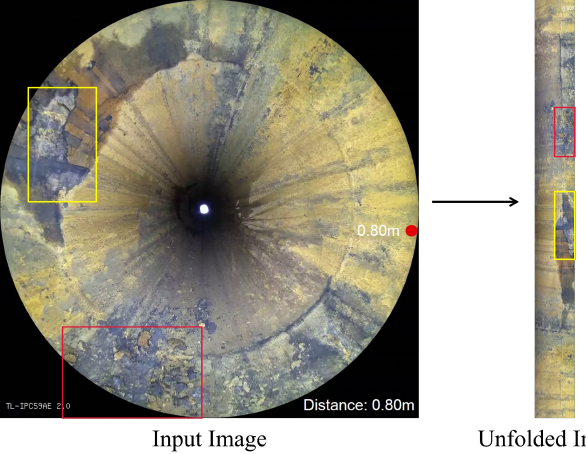
Figure 7. Unfolding